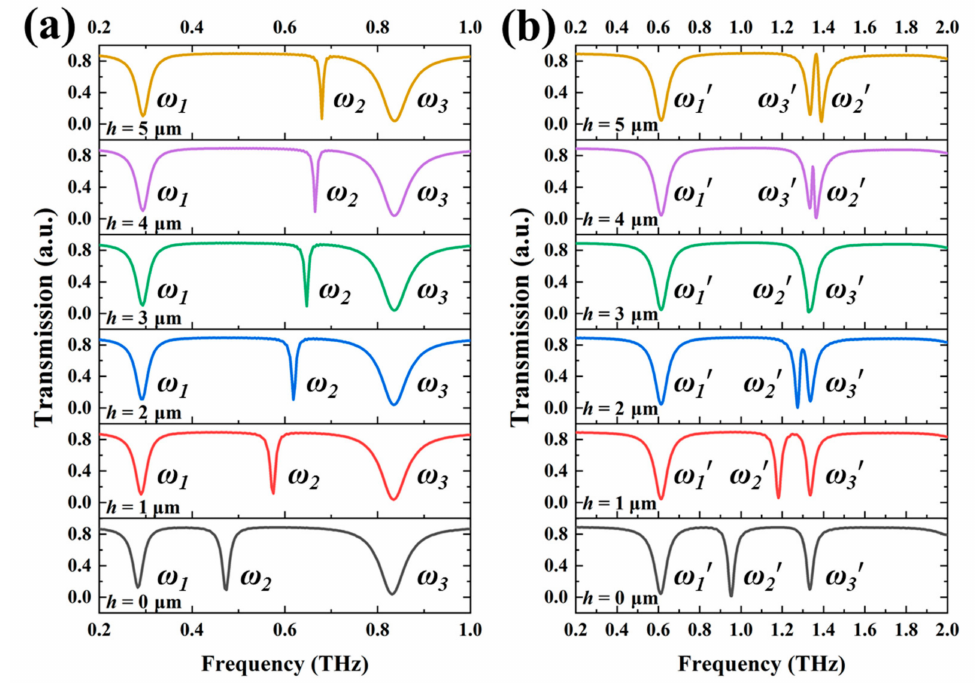
Figure 6. Transmission spectra of ( a ) TTM-1 and ( b ) TTM-2 with different h values. The relationships of resonances and h values of TTM-1 and TTM-2 are summarized in Figure 7. By changing the h value from 0 µ m to 1 µ m, the blue shifts of ω 2 and ω 2 ' are 0.101 THz and 0.223 THz respectively. With the increased h value, the frequency shift is gradually decreasing. Thus, the frequency shift of ω 2 and ω 2 ' tend to saturate after 3 µ m. Q-factor of resonance is used to evaluate the key parameter of the sensing performance, which is defined as Q = f /FWHM, where f is the resonance and FWHM is the full width of half maximum of resonance. The higher Q-factor represents the sharper resonance, which indicates that the loss of the resonance system is minor. In Figure 7, the Q-factors of